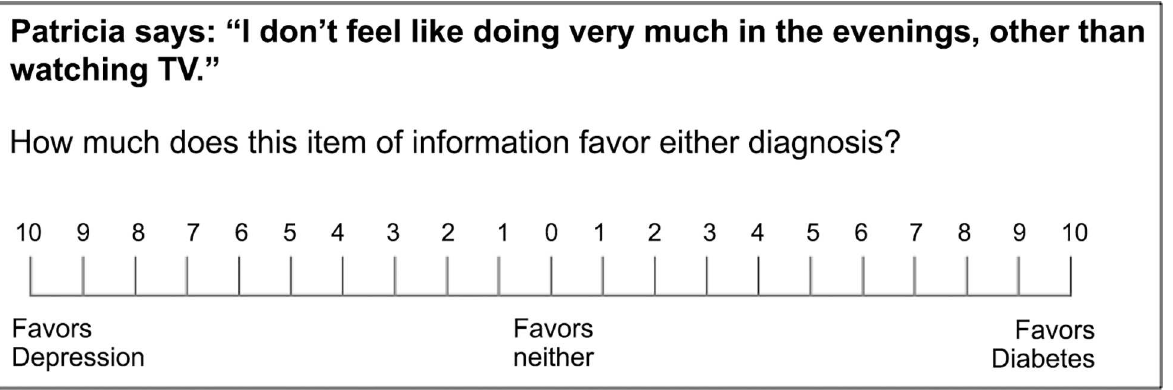
Fig 2. Scale used to collectratingsof cue diagnosticityin the single-scale group. The same scale was used by Kostopoulou et al. [15].Participants were requiredto place one markupon the